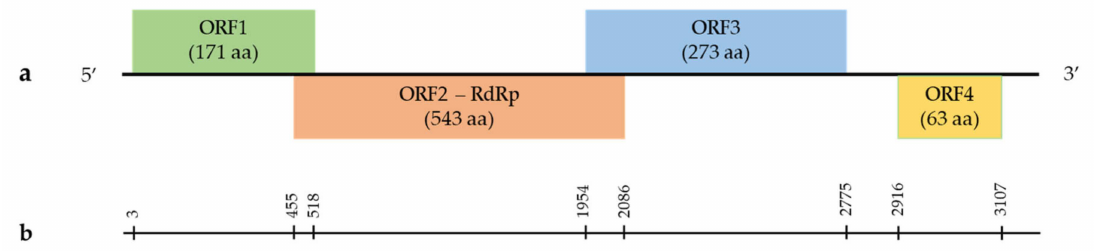
Figure 1. Schematic organization of the grapevine umbra-like virus (GULV) genome. ( a ) The genome contains four predicted ORFs: ORF1 (unknown function), ORF2 (RdRp), ORF3 (unknown function) and ORF4 (unknown function). ( b ) Nucleotide positions of GULV